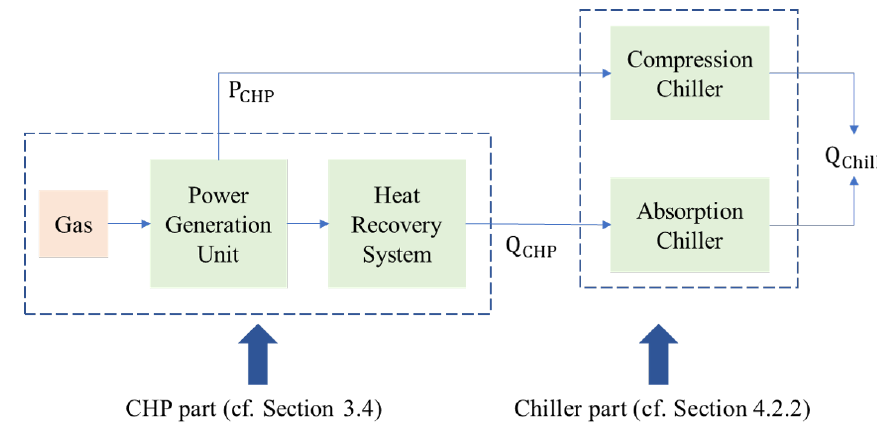
Figure 3. Schematic representation of the